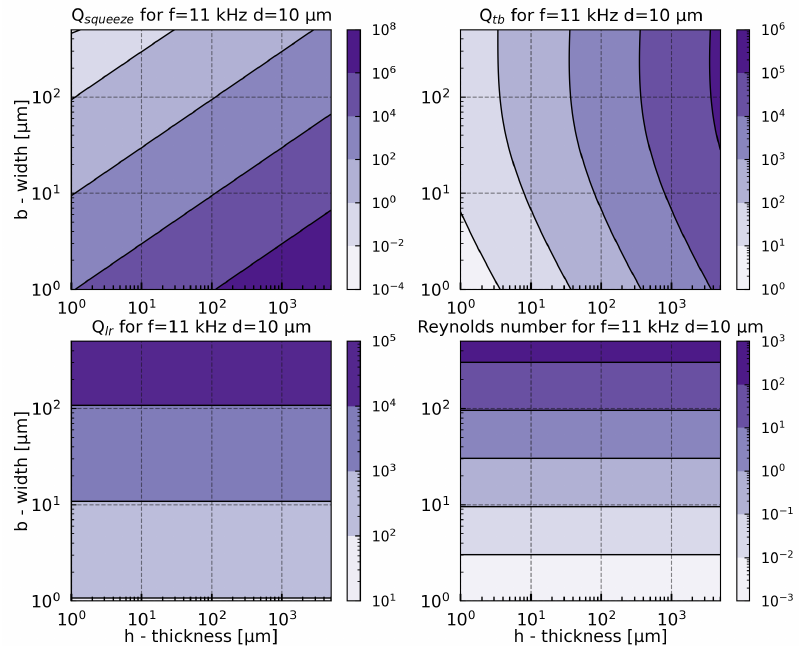
Figure A3. Quality factors for squeeze film (top-left panel), viscous damping originating from the top and bottom side of a cantilever (top-right panel), viscous damping originating from left and right side of a cantilever (bottom left panel) and Reynolds number (bottom-right panel) as a function of width and thickness of a cantilever. Cantilever’s fundamental resonance frequency: 11 kHz, gap between support and cantilever: d = 10 µ m.